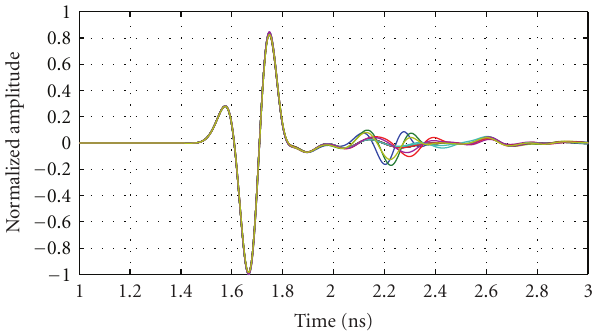
Figure 12: Simulated calibrated reflections from the breast phan- tom at 20 antenna locations encircling the phantom. Reflections are simulated with the antennas positioned at the same z -location as the inclusion.